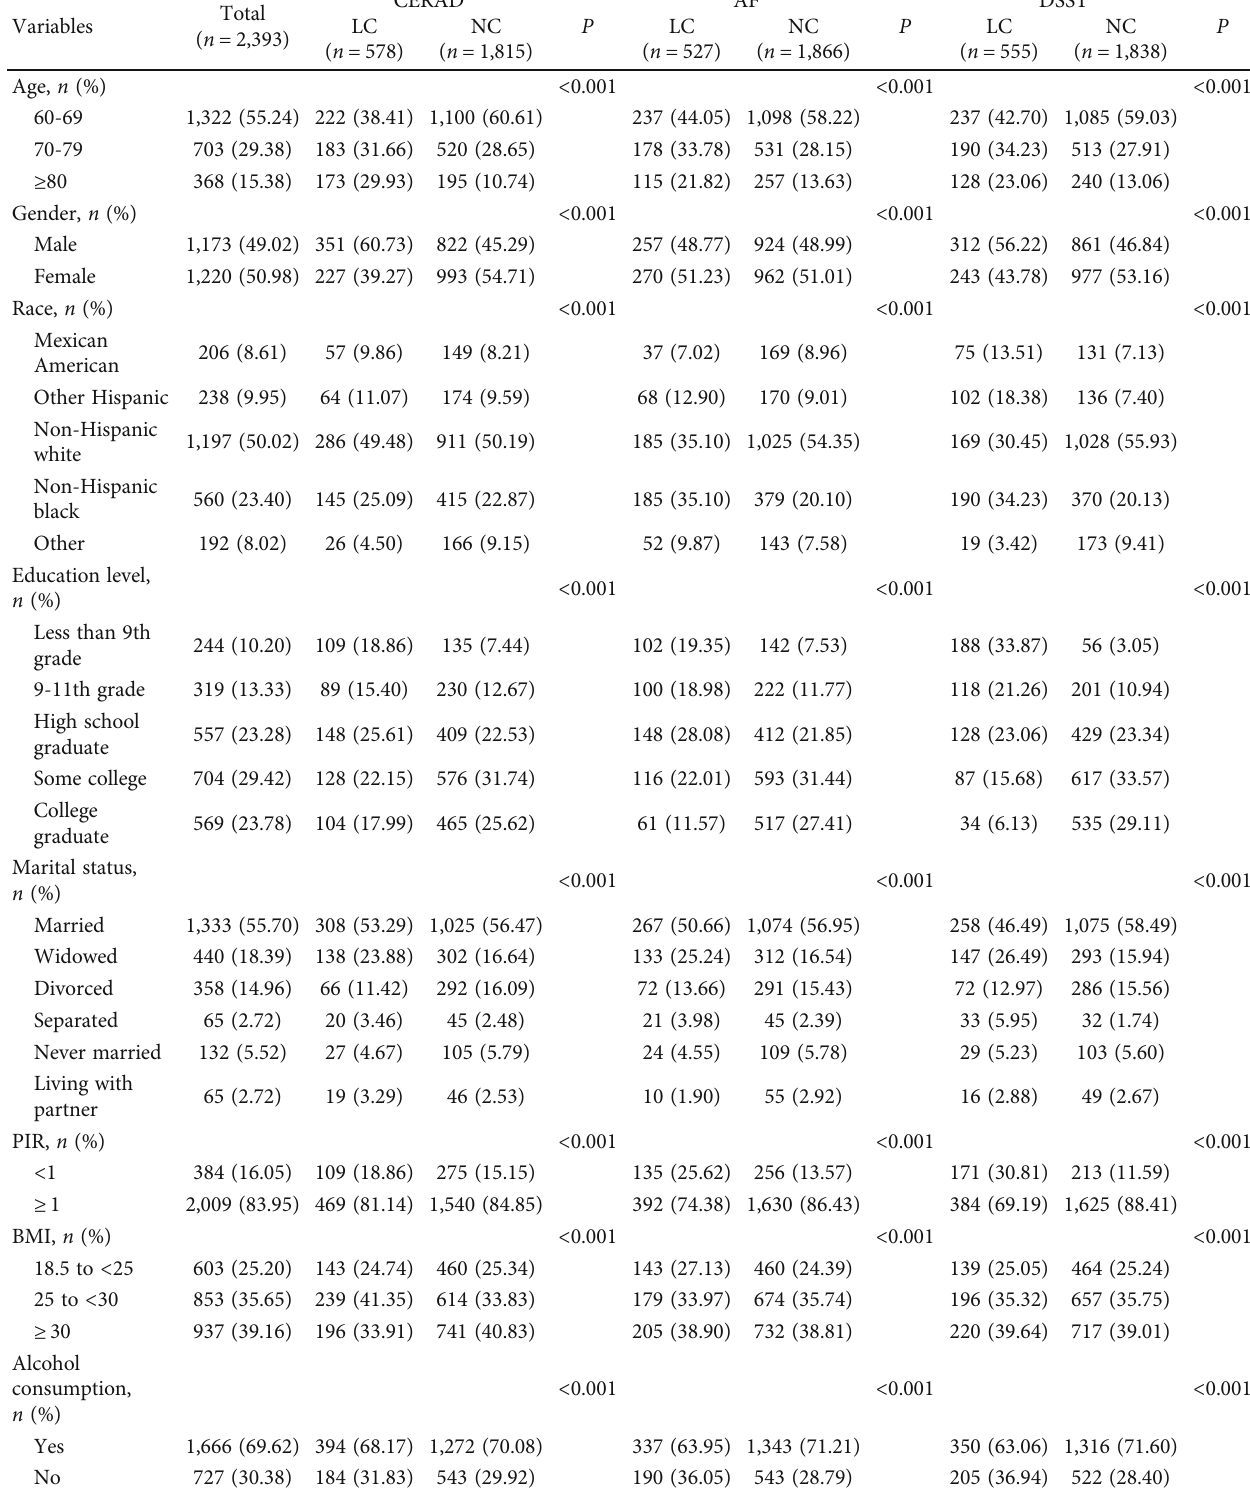
Table 1: Baseline characteristics of the 2,393 study participants, 2011-2014